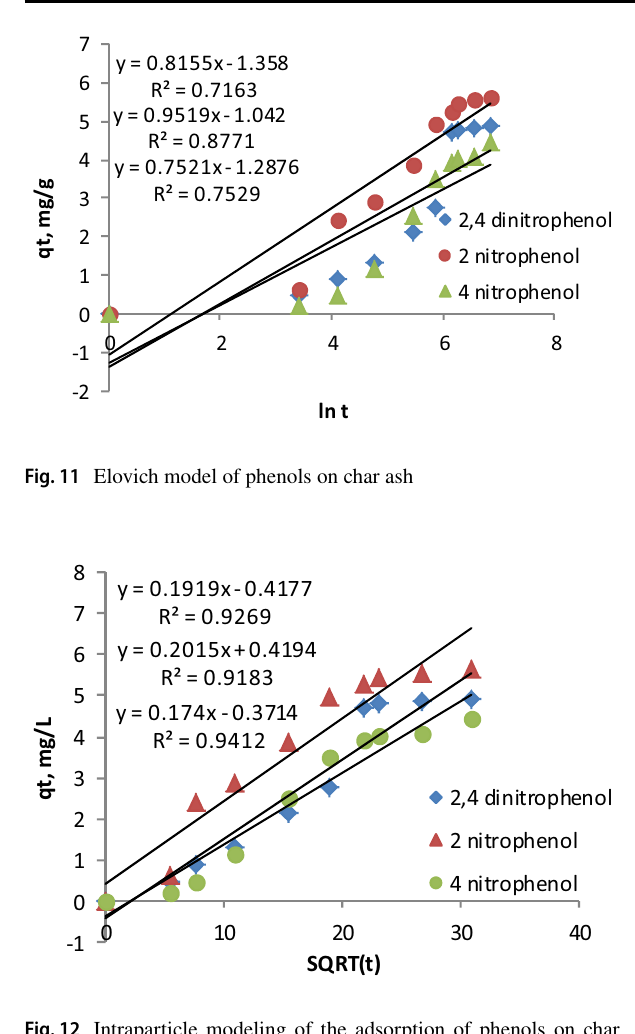
Fig. 12 Intraparticle modeling of the adsorption of phenols on